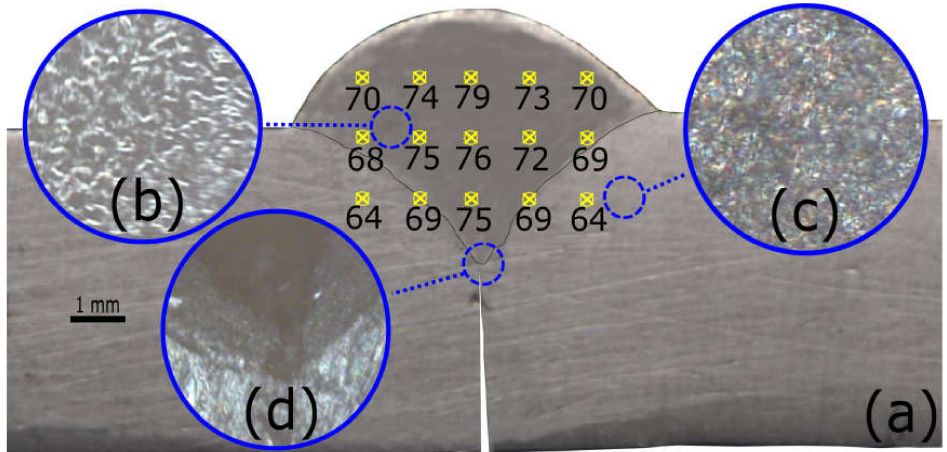
Figure 4. ( a ) Image obtained by the microscope showing the different phase changes in the welded joint; ( b ) Ferrite and perlite in the weld cord; ( c ) Ferrite and perlite in the base metal cord; and, ( d ) Reduced area of the Heat-Affected Zone (HAZ).